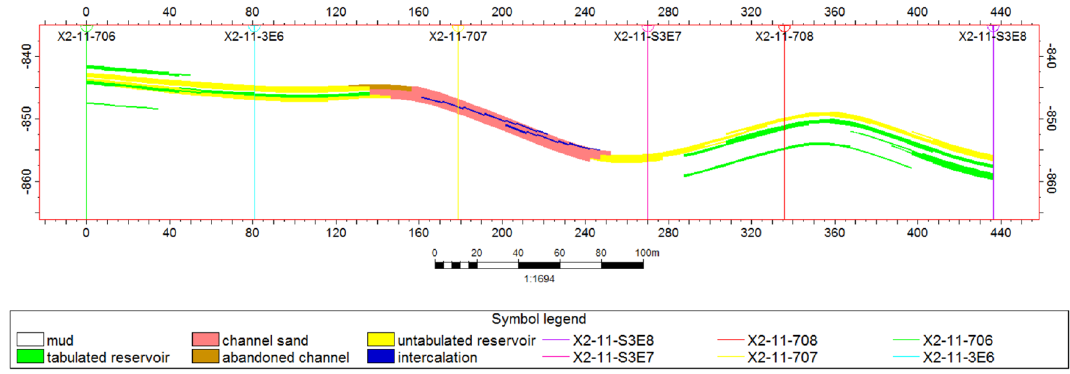
Fig. 5 Profile 1 of reservoir architecture model in study